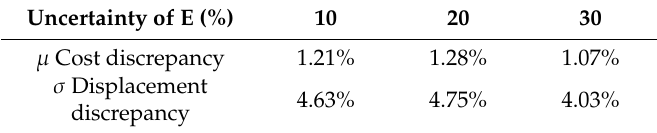
Table 3. Validation of the kriging surfaces while varying the modulus of